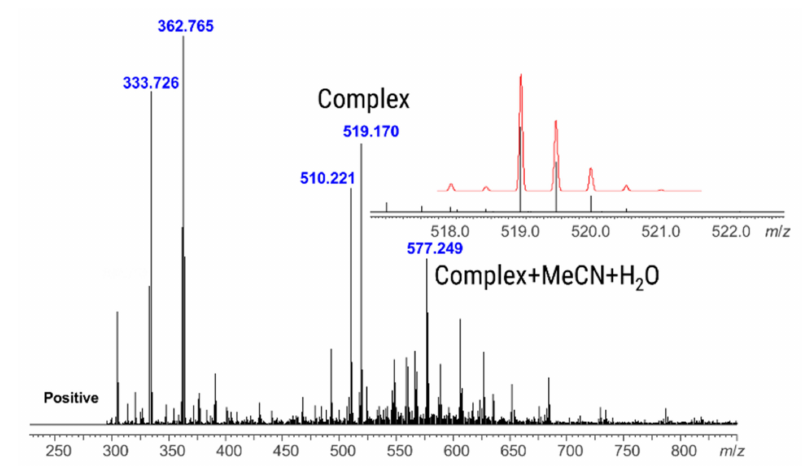
Figure A1. ESI-TOF-MS of the NHC iron complex with isotopic distribution. The reaction with NiCl 2 (PPh 3 ) 2 yielded a yellow solution that turned brown over time. The 1 H-NMR spectrum revealed sharp signals and a shift of the protons compared to 5 and the imidazolium proton was absent (Figure S16). When 4 was heated with RuCl 3 · x H 2 O in the presence of silver oxide, the yellow suspension turned blue upon gentle heating, However, 1 H-NMR spectroscopy only revealed the ligand’s signals. When air was introduced, the solution slowly turned black; this process was slowed down when the sample was kept at 5 ◦ C. When attempting the synthesis from the silver salt 5 , a brown precipitate was observed upon addition of the ruthenium salt. The 1 H-NMR spectrum again showed signals assignable to the ligand, and the imidazolium proton was recovered. This behavior might explain why the Fe(II) complex decomposes so rapidly, since its properties are expected to be similar to those of the Ru(II)